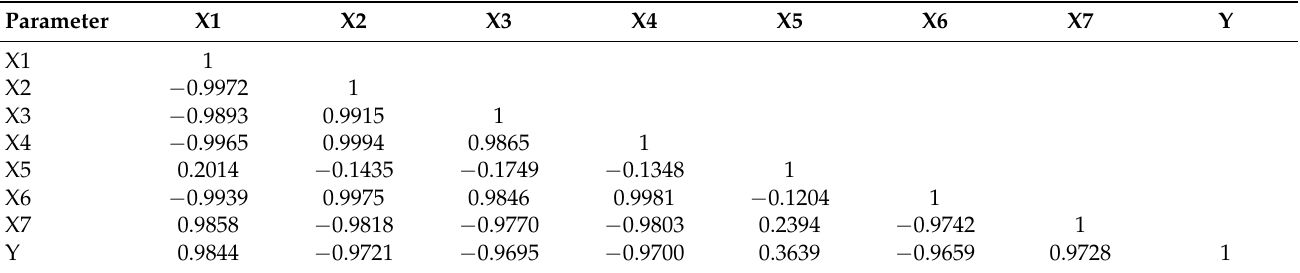
Table 2. Pearson correlation coefficients for inputs and the target